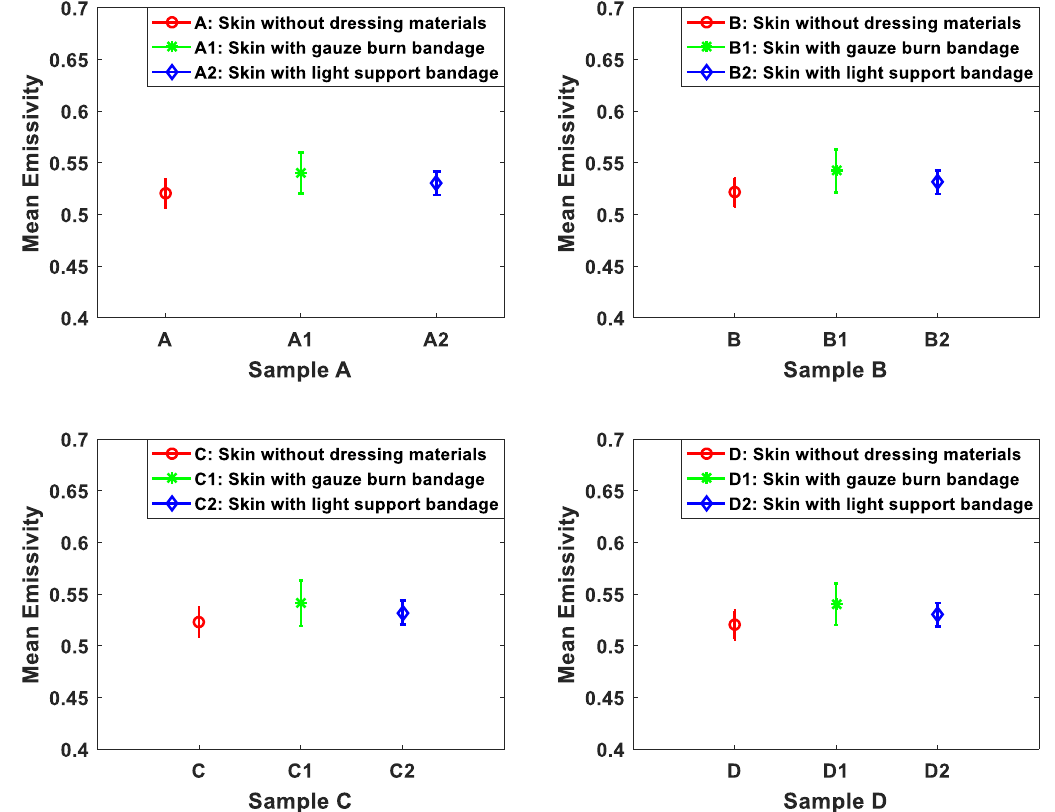
Figure 7. Mean emissivity values and standard deviation bars for porcine skin without and with dressing materials. The samples A, B, C, and D represent skin without dressing materials, A1, B1, C1, and D1 represent skin with six-layer gauze burn bandage, and A2, B2, C2, and D2 represent skin with a light support bandage.